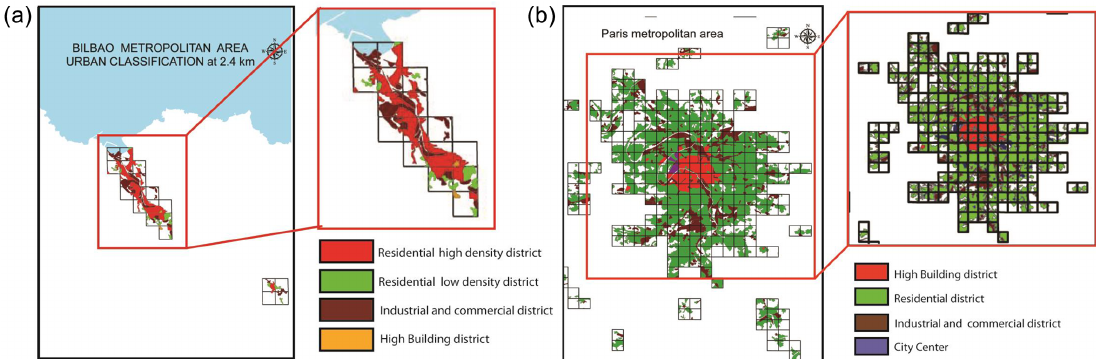
Figure 9. Urban district classification based on urban zoning data for the (a) Bilbao and (b) Paris metropolitan areas, including the resi- dential area (ReD), low and high building districts (LBDs and HBDs, respectively) and industrial and commercial districts (ICDs). Spatial distribution of urban districts (HBDs – high buildings, RDs – residential, ICDs – industrial commercial and CCs – city centre districts) for the Paris metropolitan area within the P01 modelling domain (partly adopted from González-Aparicio et al., 2014) is